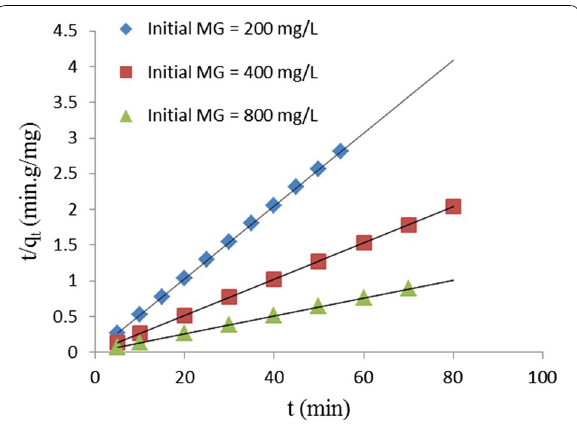
Fig. 8 Pseudo-second order kinetic plot for removal of MG by TLLP